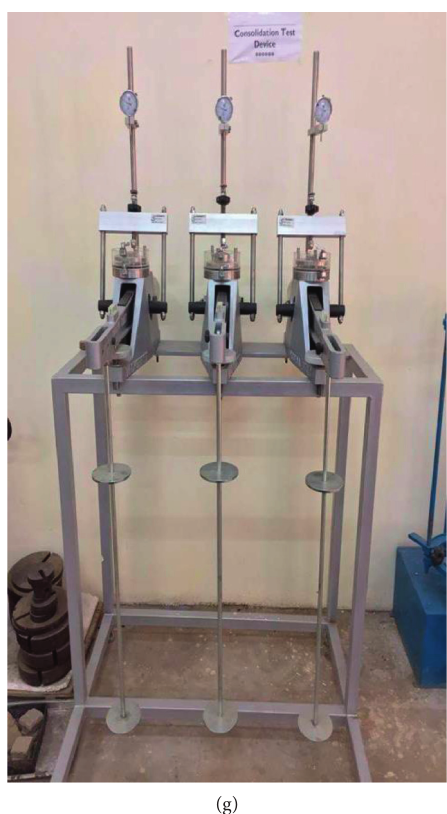
Figure 2: Brief overview of site sampling, specimen preparation, and laboratory testing. (a) Diagonal crack in boundary wall. (b) Prevalence of desiccation cracks. (c) 1.5m × 1.5m excavated pit. (d) UCS samples prepared for curing. (e) Samples cured (7, 14, 18, 56, and 112 days). (f) UCS machine (Modena, Italy). (g) Oedometer test assembly (Modena,